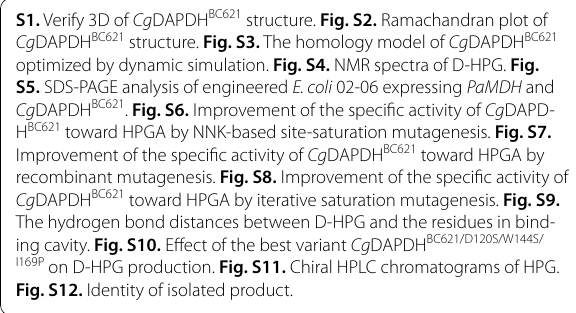
Fig. S12. Identity of isolated product.